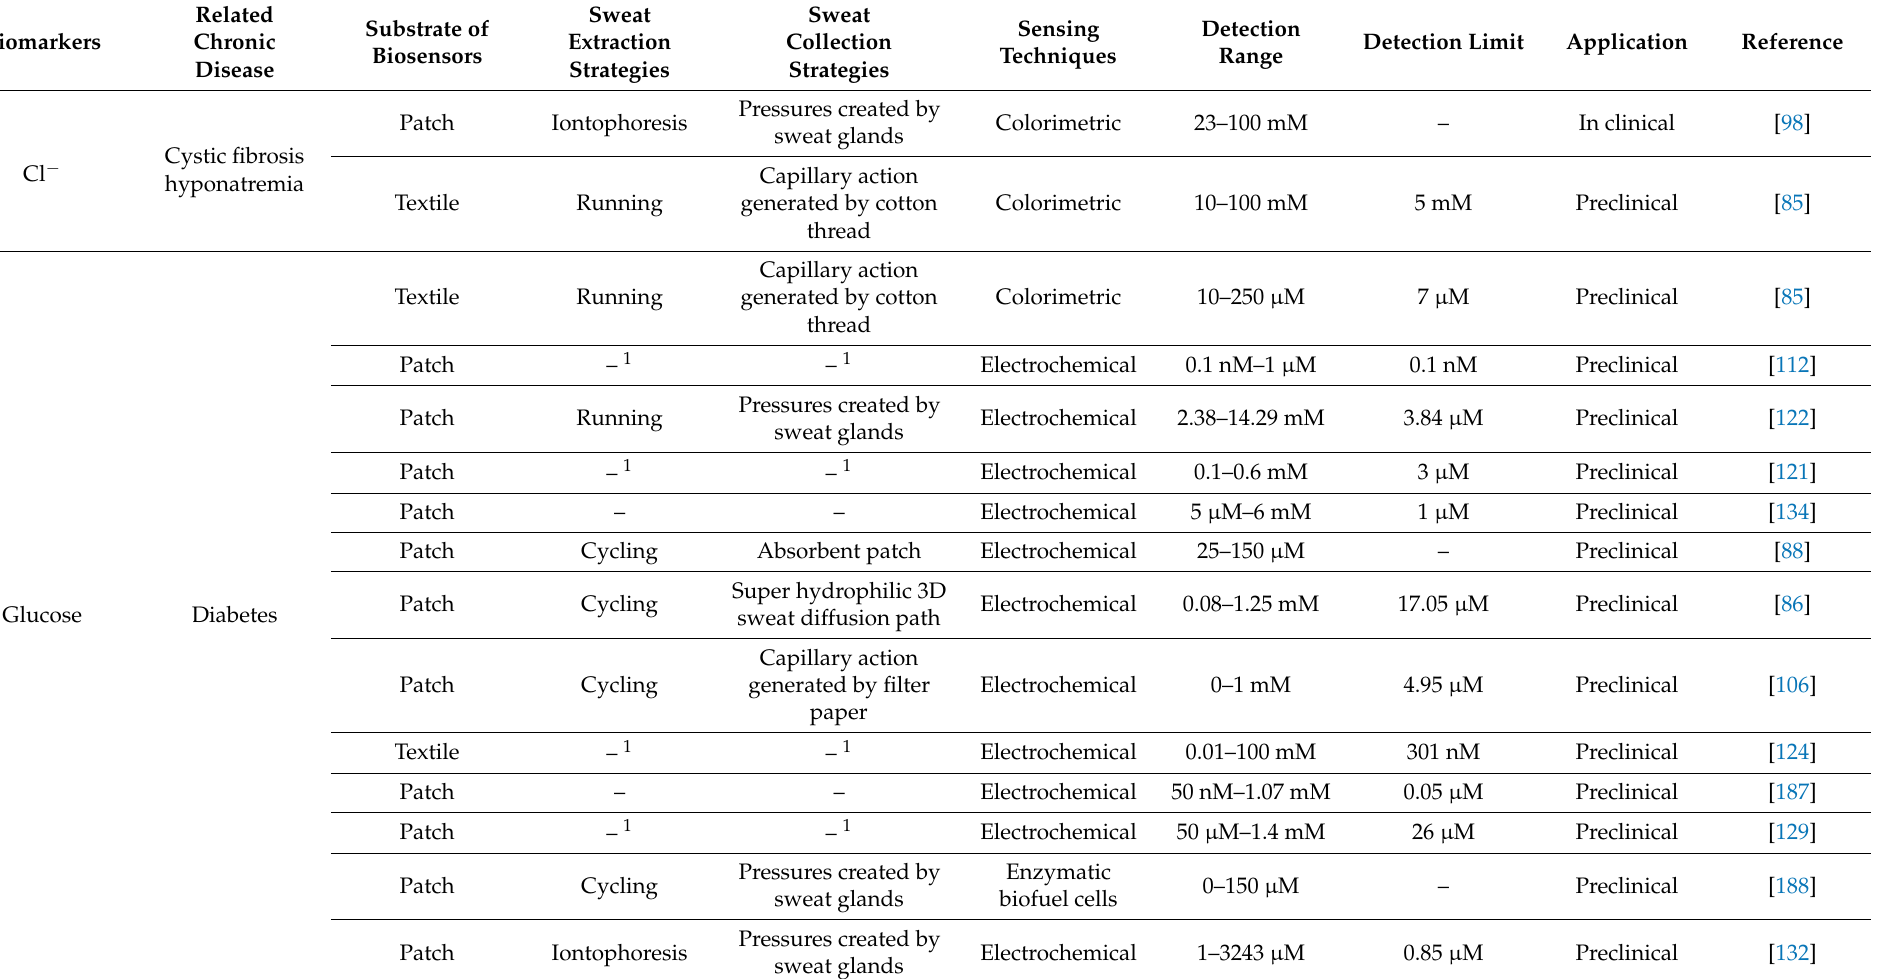
Table 3. Epidermal wearable biosensor-based sweat biomarker analysis in clinical and preclinical